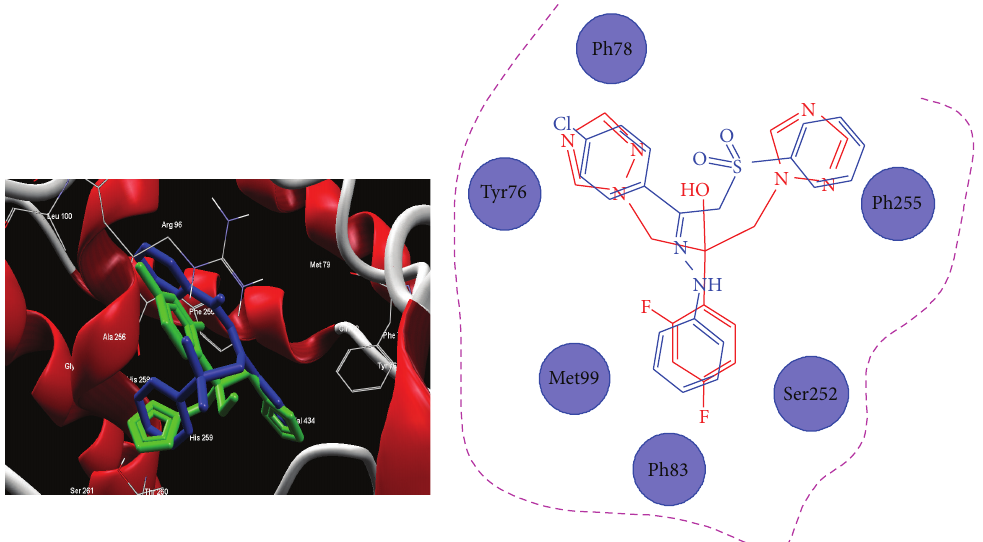
Figure 3: Overlay of compound 13 (blue) and fluconazole (red) showing their 3D and 2D binding interactions in the groove of cytochrome P450 14 𝛼 -sterol demethylase.